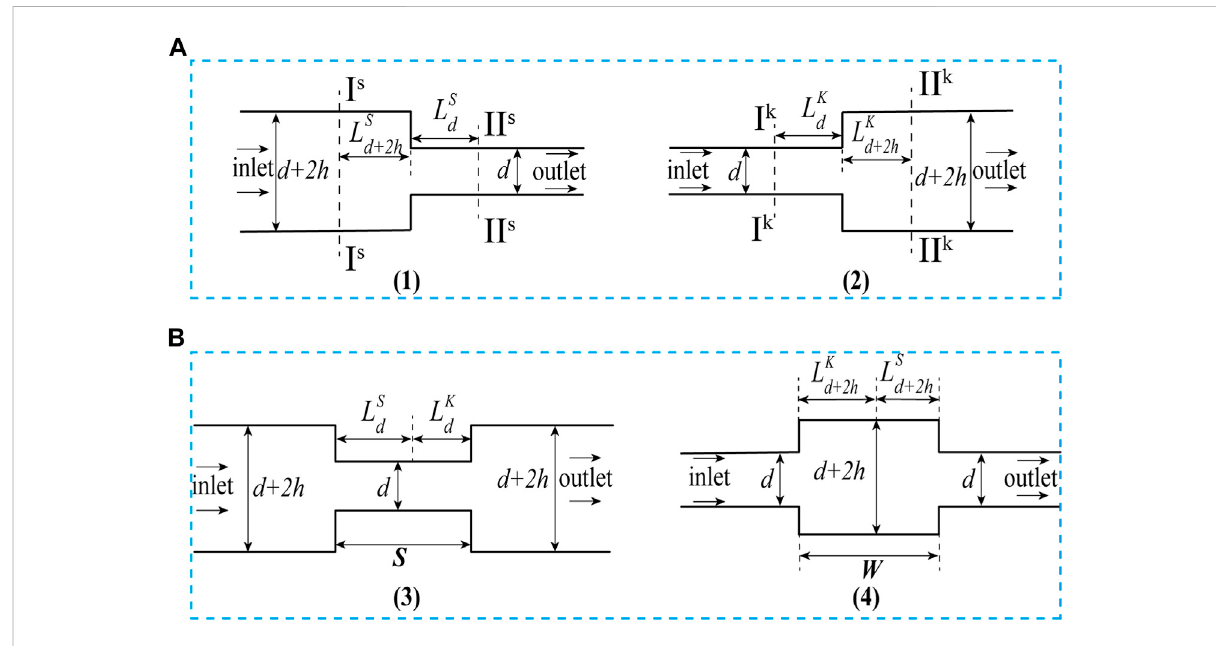
FIGURE 3 Schematic diagram of Single-Type and Comprehensive-Type structure. (A) Single-Type structure, (B) Comprehensive-Type